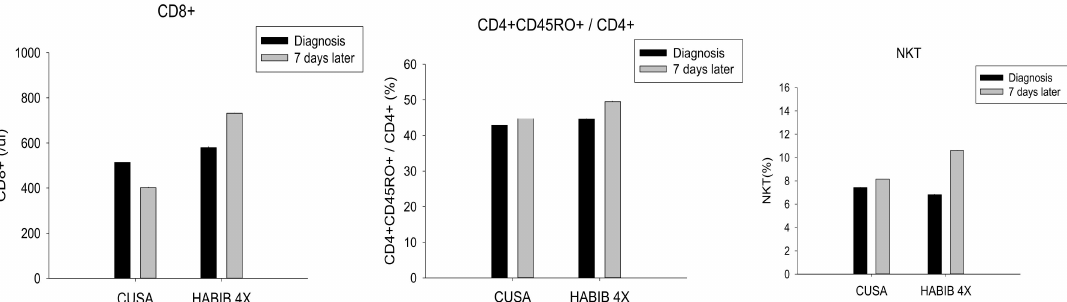
Figure 3. Cytotoxic CD8 T cells, CD4 + CD45RO + /CD4 + and NKT cells changes in both study groups. A significant increase was observed in all three cell types in the Habib TM 4X group.